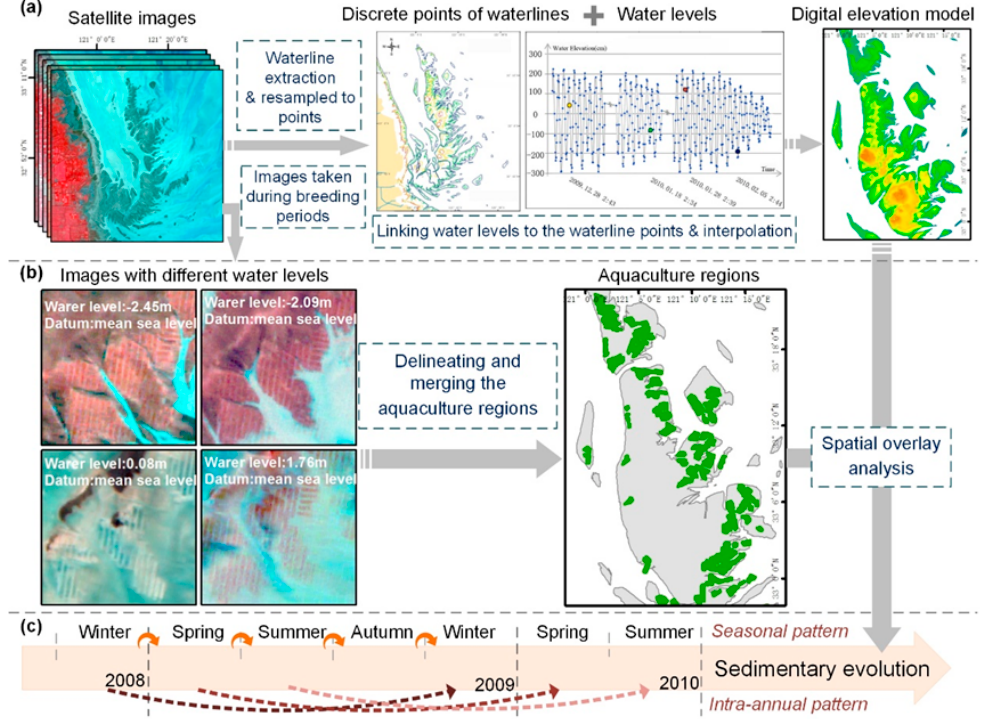
Figure 2. Flow chart illustrating the methodology used in this study. ( a ) Digital elevation model construction; ( b ) aquaculture region extraction; and ( c ) sedimentary evolution based on a time series.